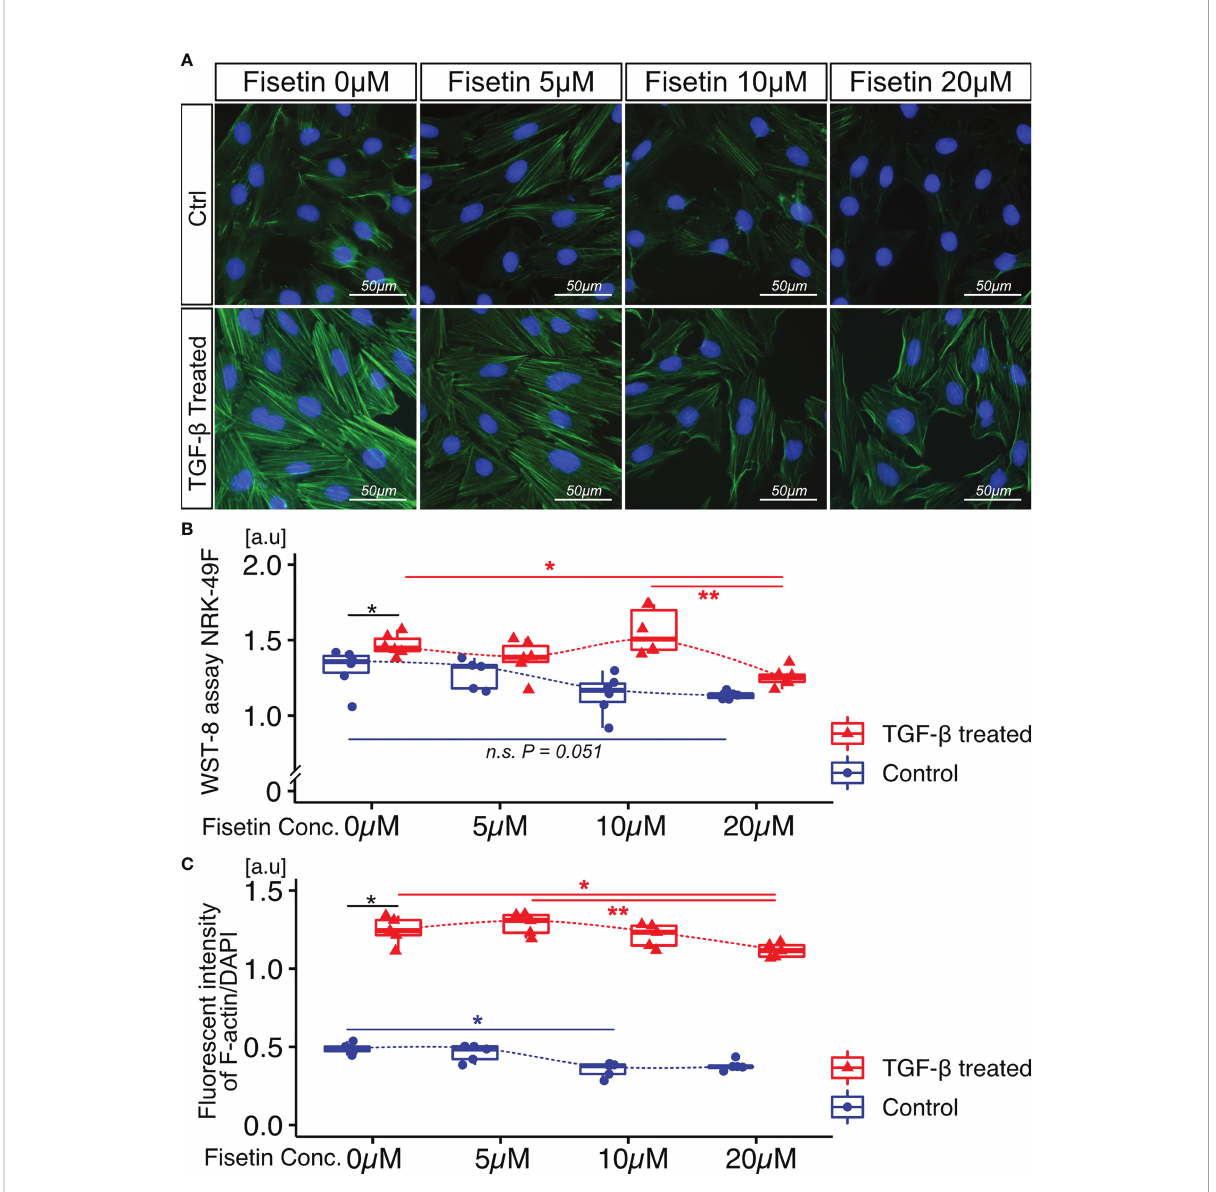
FIGURE 4 Fisetin treatment reduces cell proliferation and F-actin expression in TGF- b 1 – stimulated NRK-49F cells. (A) Representative images of F-actin staining in TGF- b 1 – stimulated NRK-49F cells with and without fi setin treatment (0, 5, 10, 20 µM). (B) WST-8 cell proliferation assay of NRK-49F cells after TGF- b 1 and fi setin treatment. (C) Quanti fi cation of F-actin expression levels in NRK-49F cells measured using a fl uorescence microplate reader. P -values were determined using two-way ANOVA adjusted by Tukey ’ s method (*P < 0.05 and **P <